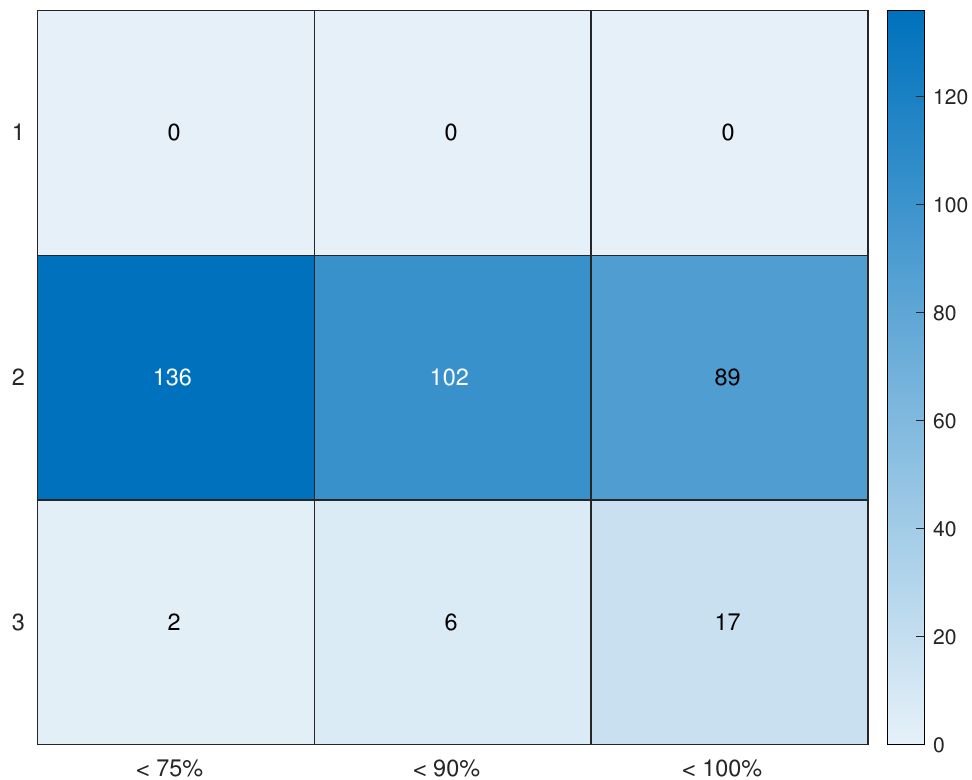
Figure 3. Heatmap of number of days divided by percentage of consistent data (column) and zone with most of the data in